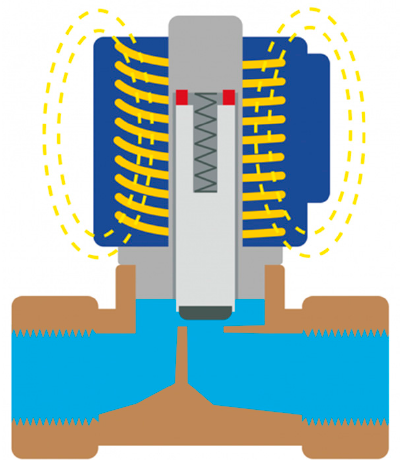
Figure 6. The inner structure of a typical solenoid valve.